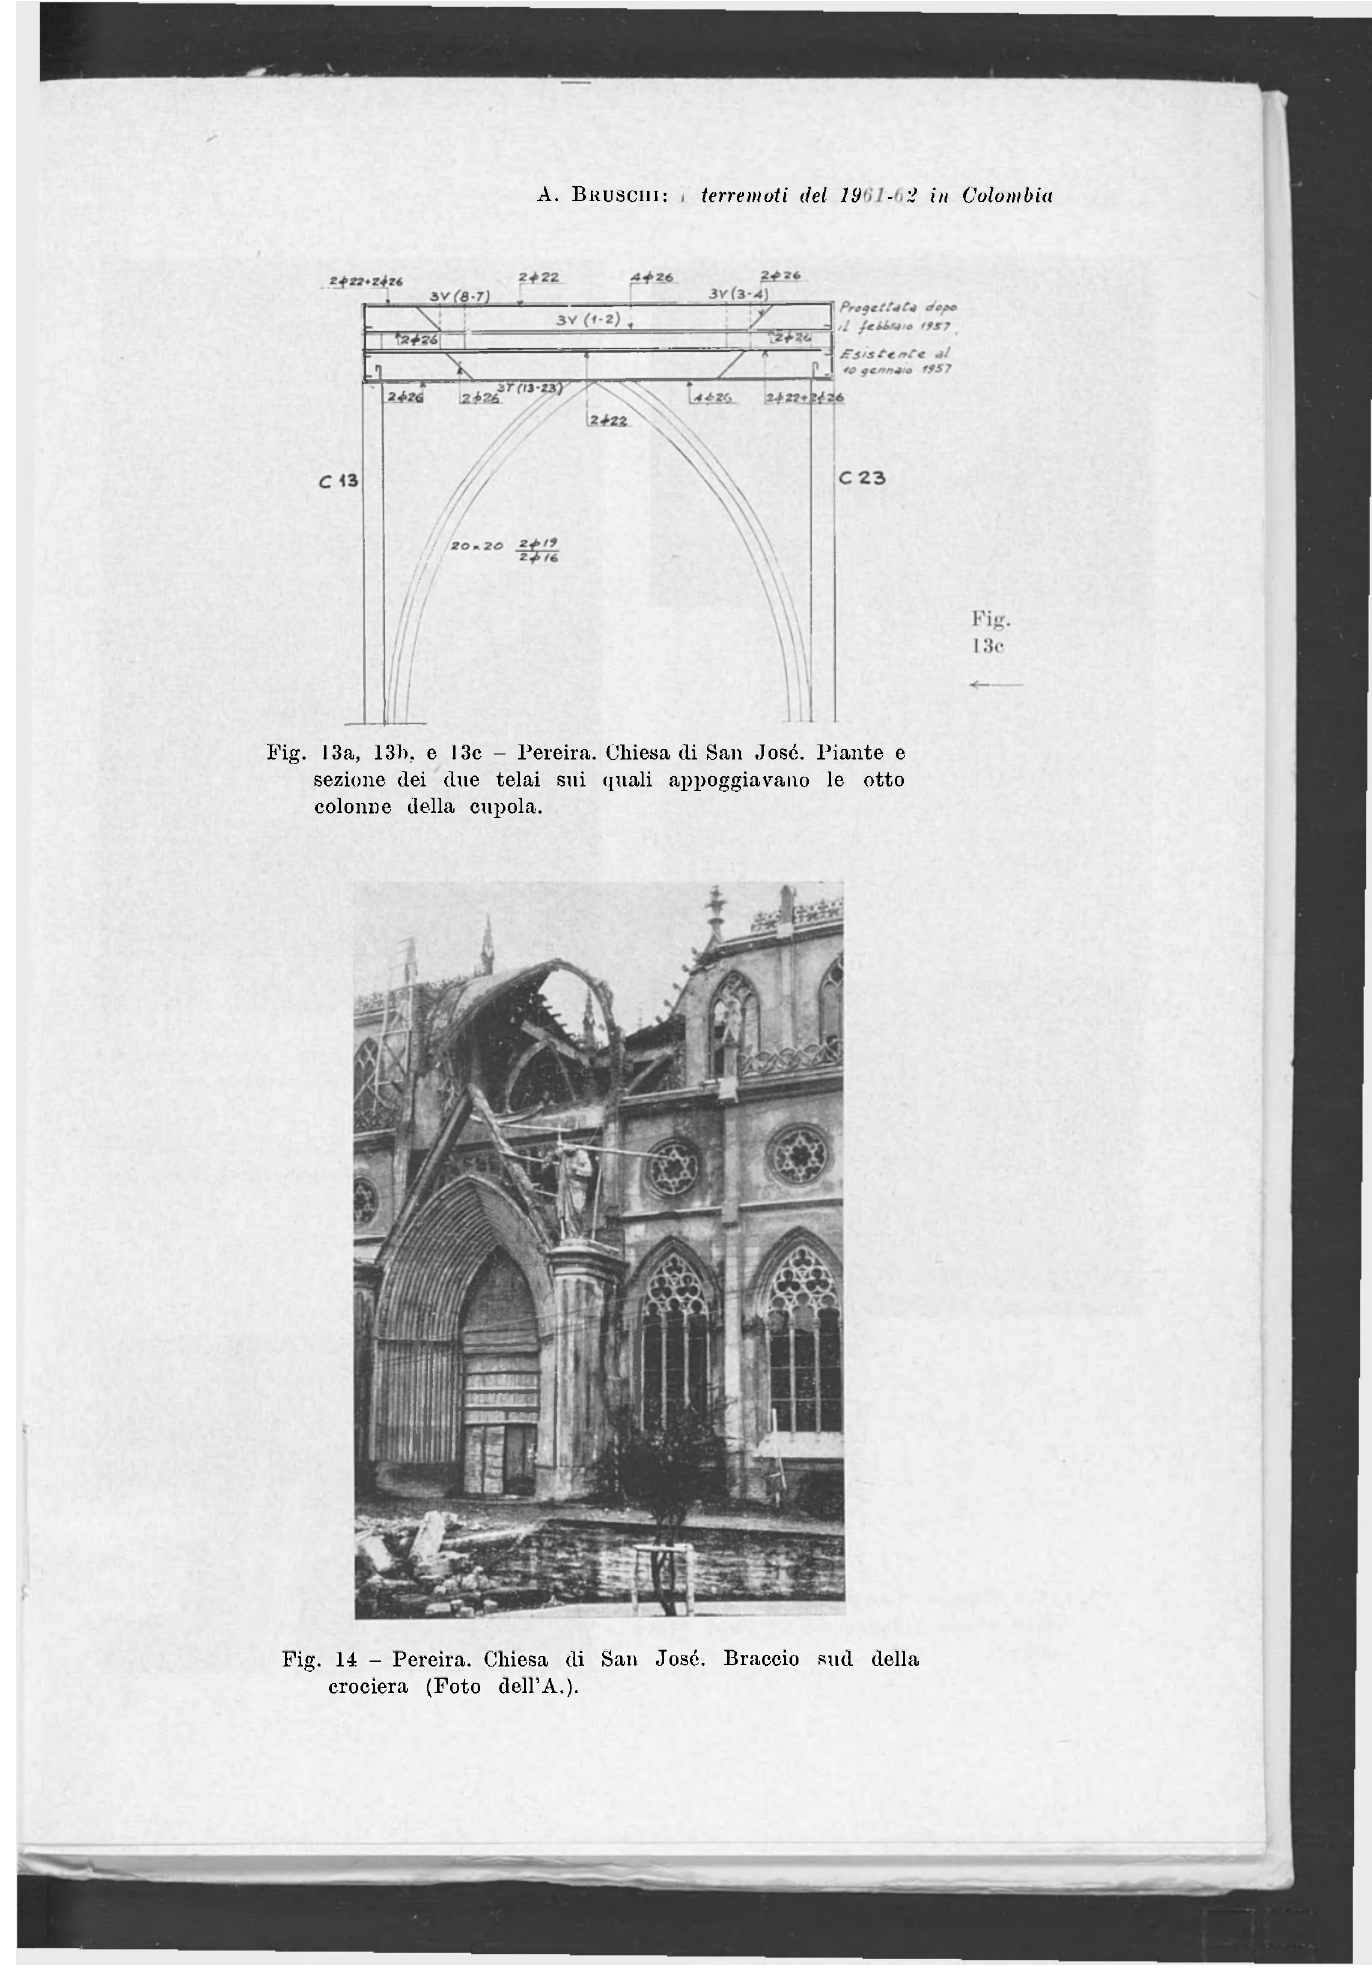
Fig. 14 - Pereira. Chiesa di San José. Braccio sud della crociera (Foto